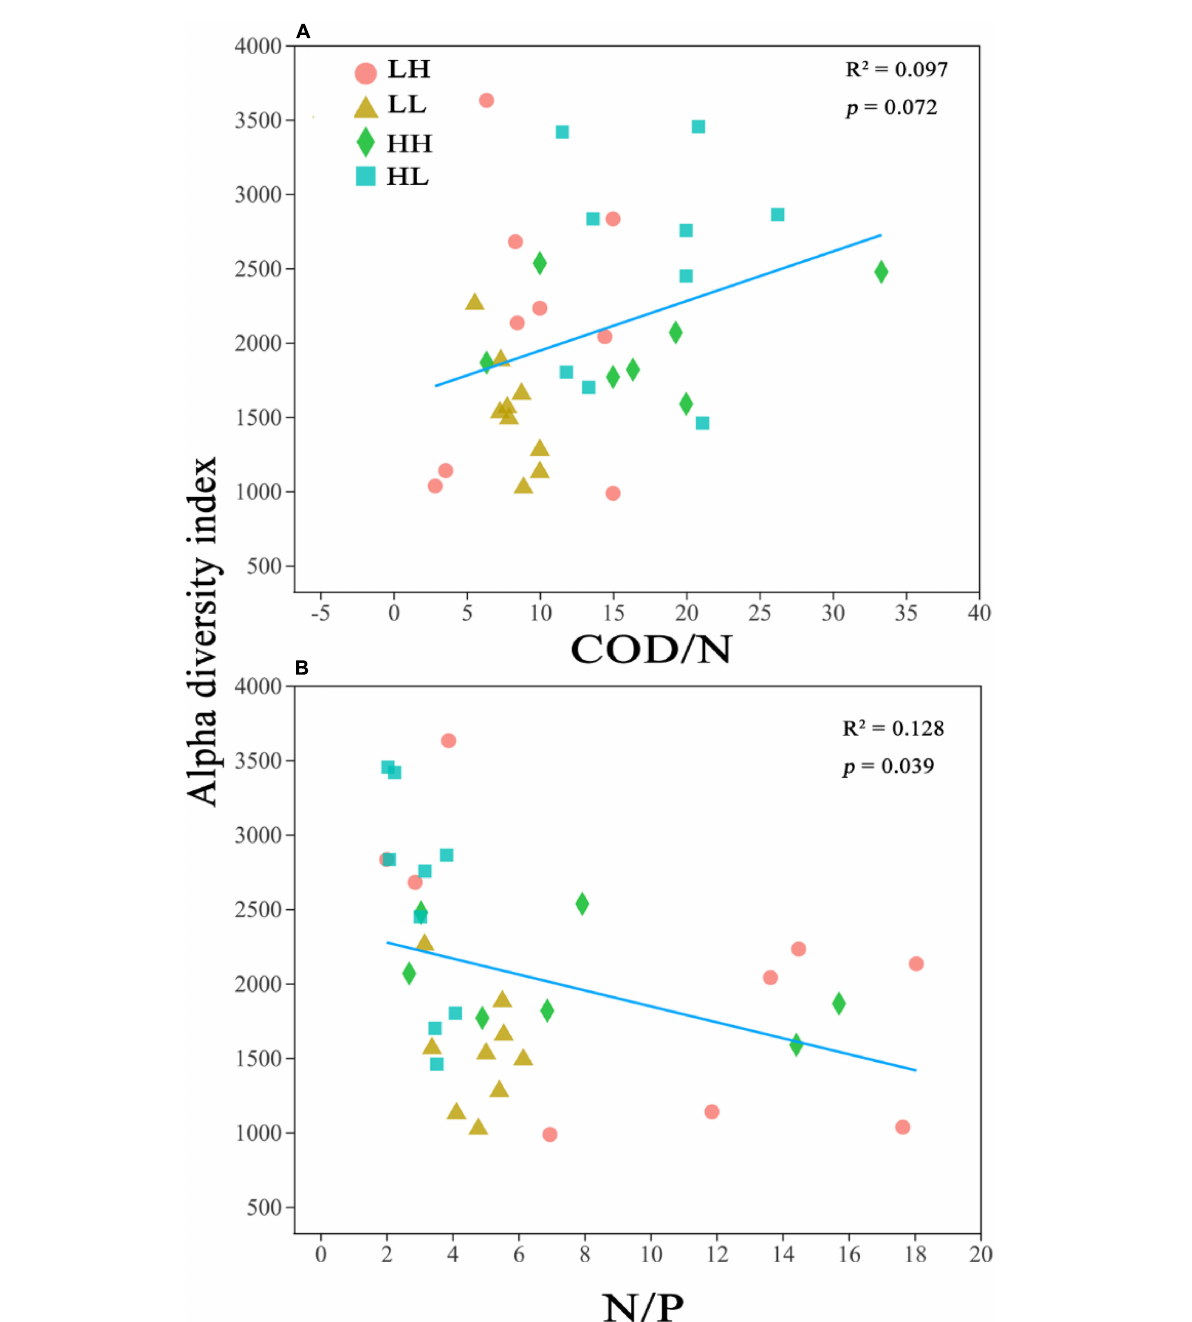
results indicated that COD and COD/N were negatively and significantly related to beta diversity ( R 2 = 0.435 and 0.332, respectively; p < 0.001), while NH 4 + -N was positively connected with beta diversity ( R 2 = 0.149 and p =